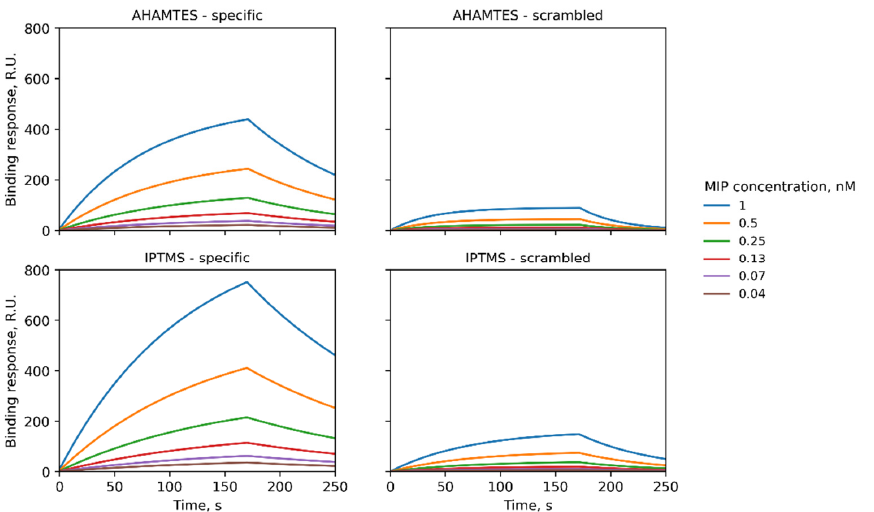
Figure 1. Scanning electron microscopy (SEM) images of MIPs prepared using: ( a ) AHAMTES ‐ based solid phase, ( b ) IPTMS ‐ based solid phase. Scale bar = 2 μ m.